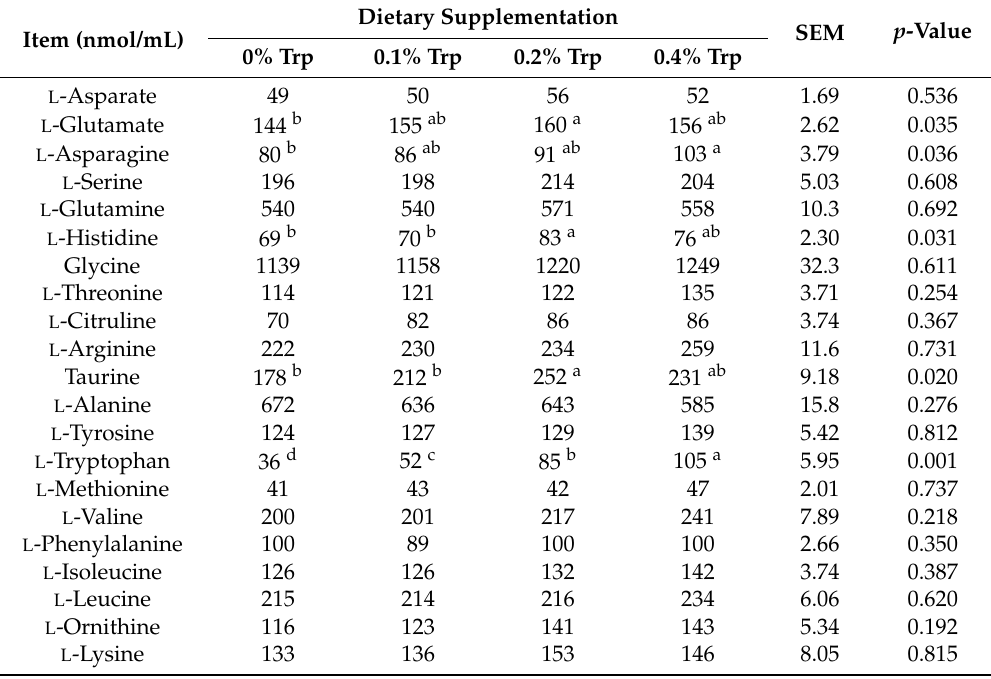
Table 1. The concentrations of amino acids in the serum of weaned piglets receiving dietary supplementation with L -tryptophan 1